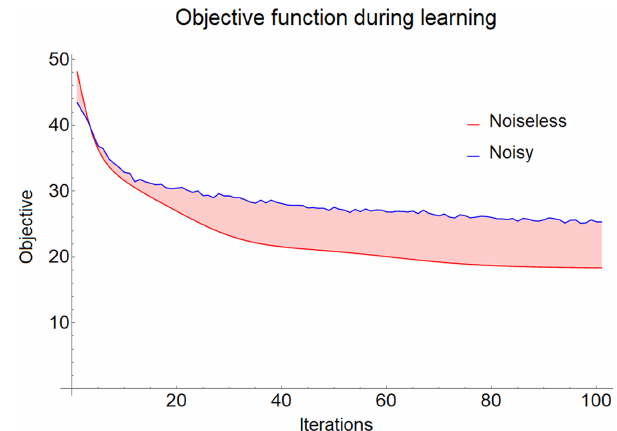
FIG. 4. Three-dimensional illustration of our data set for train- ing. Here we use three inputs x [0, 1, 2] and label them with 0 or 1, colored by red or blue, respectively. The data set is generated using ad_hoc_data .